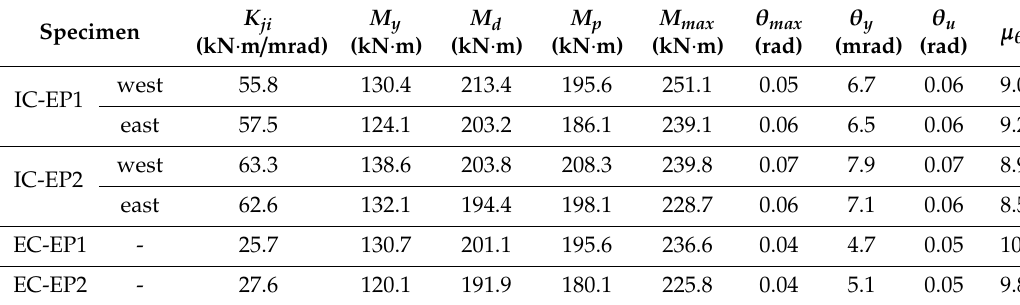
Table Note: K ji is the initial rotational stiffness of the joints; M y , M d , M p , M max , θ max , θ y , and θ u are defined by the key parameters of the connections, μ θ is the ductility coefficient of the test specimen, μ θ = θ u / θ y .